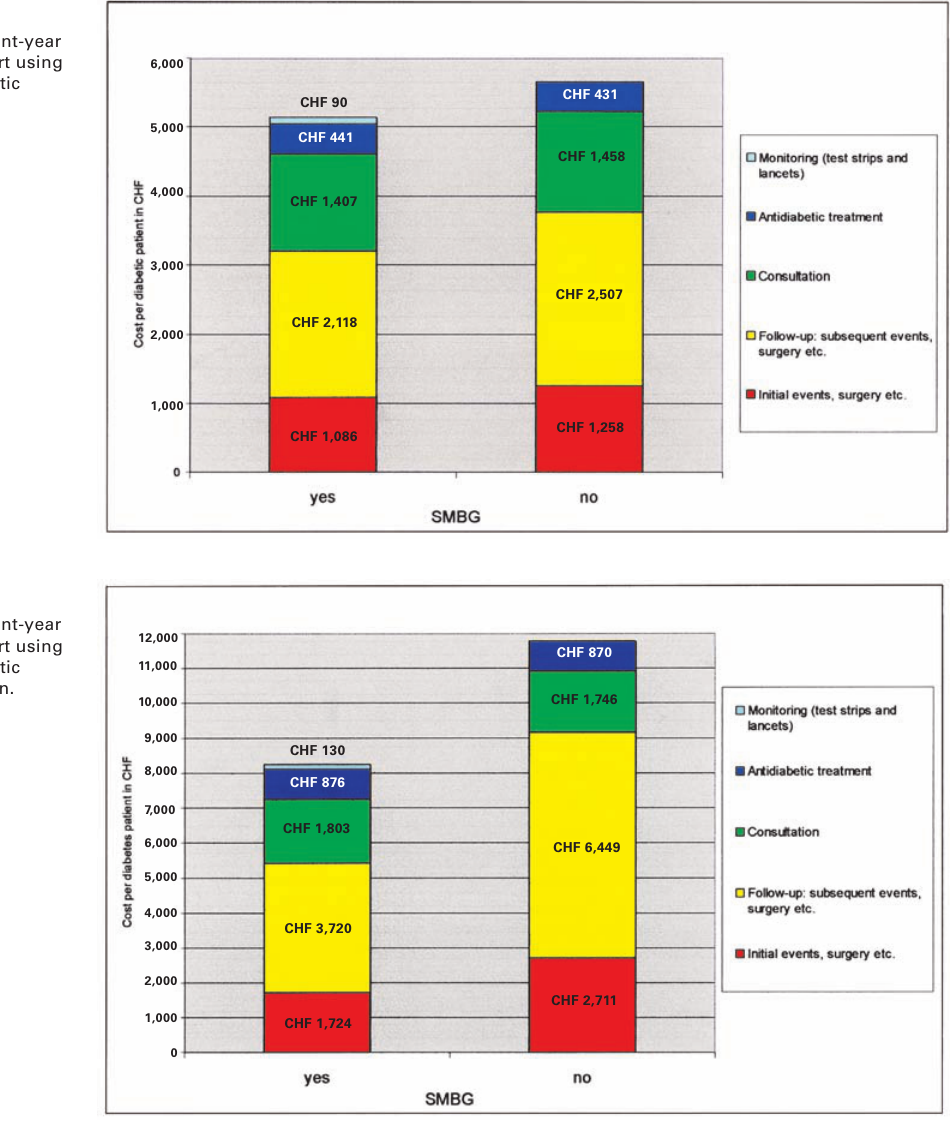
Cost per patient-year (CHF) in cohort using oral antidiabetic drugs +